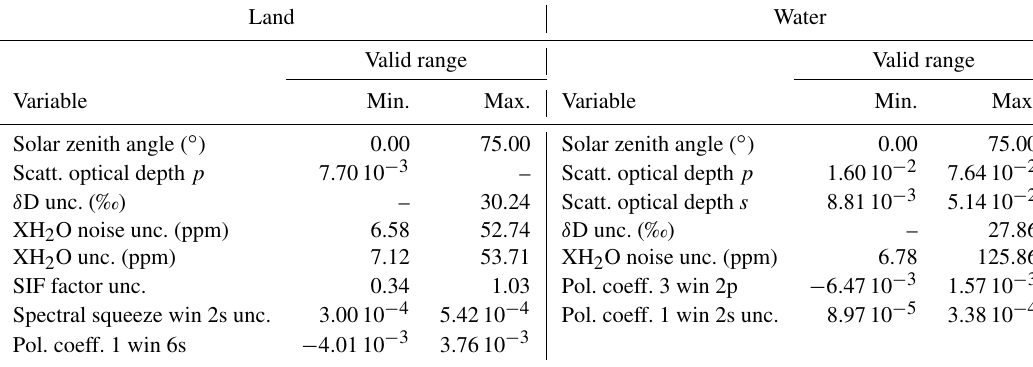
Table A10. δ D filter variables and limits for GOSAT-2. “–” means that no limit is applied. Except for the solar zenith angle limits, the variables are ordered by their relevance, i.e. by the number of data filtered